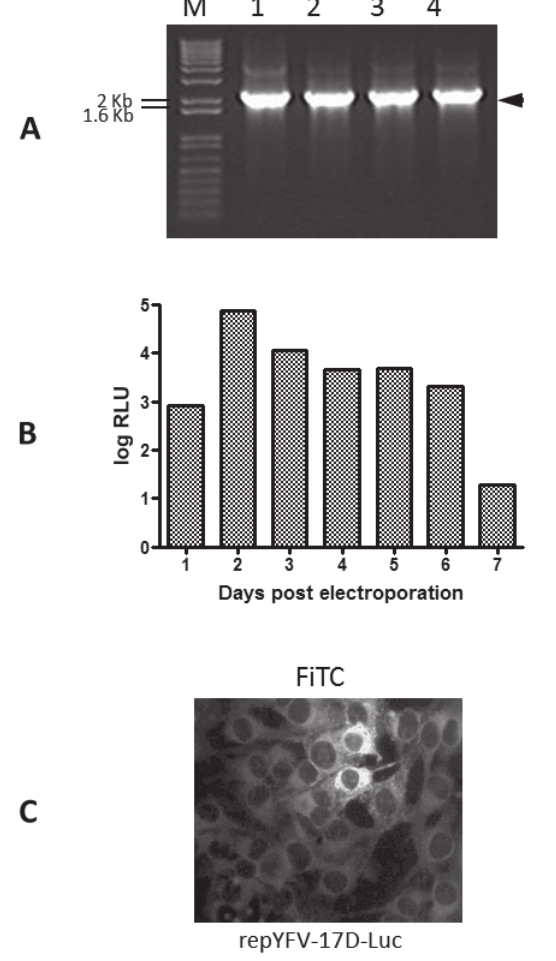
Figure 2 - Characterization of the subgenomic replicon repYFV-17D- GFP. (A) Confirmation of the cloning of four clones repYFV-17D-GFP by homologous recombination in yeast. Agarose gel electrophoresis of the expected PCR product of 1,272 bp. The numbers correspond to clone tested (1-4). (B) Detection of protein expression of yellow fever virus by indirect immunofluorescence 48 hours after electroporation of BHK21 cells with RNA in vitro transcribed of repYFV-17D-GFP. (C) Detection of GFP expression by confocal microscopy in cells BHK21 electroporated with the replicon repYFV-17D-GFP (upper) and with Green Lantern DNA (botton) 48 hours post- electroporation.